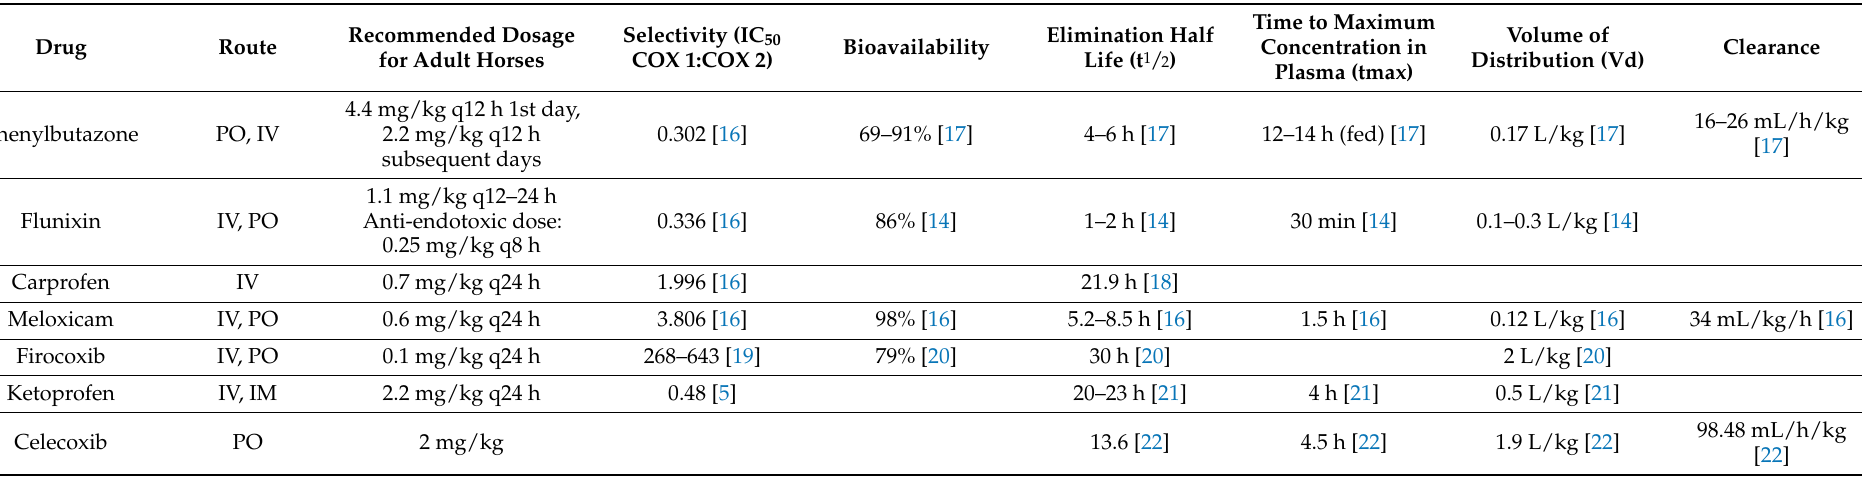
Table 1. Route, recommended dose, IC 50 COX 1:Cox 2 selectivity, bioavailability, elimination half life (t 1 / 2 ), time to maximum concentration (tmax), volume of distribution (Vd) and clearance of common NSAIDs used in equine practice in adult horses.